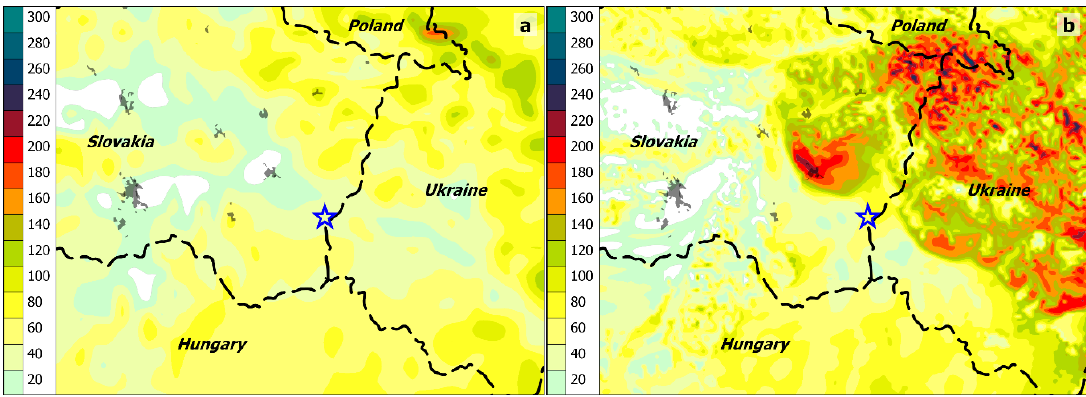
Figure 11. Forecast on 3 October 2018 06:00 UTC of 12:00 UTC storm relative helicity in 0–1 km layer (m 2 s –2 ) over eastern Slovakia based on ( a ) NWP OPM and ( b ) ELAM. Country names shown in italics; tornado location highlighted by blue star.